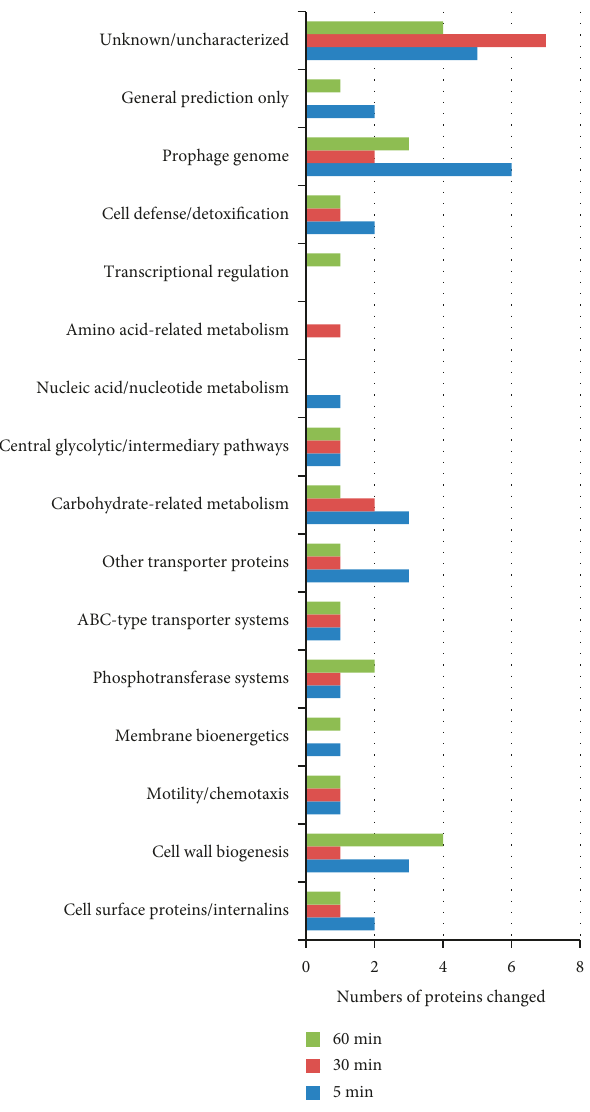
Figure 2: Numbers of protein changed significantly, for the log ratio of the fold change in protein abundance ≥ 0.5 or ≤− 0.5, in each functional classes during the inactivation process in TSB-YE with pH 3.5 and a w 0.90 with sampling time at 5min, 30min, and 1hr at 25 ° C for a time-course